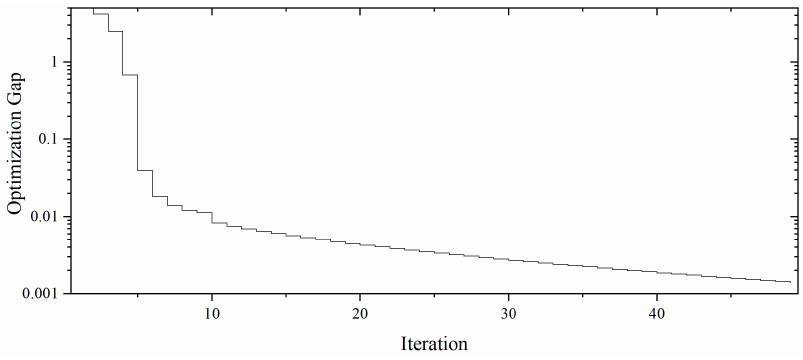
Figure 11. Optimization Gap of Decentralized Operation based on ADMM.